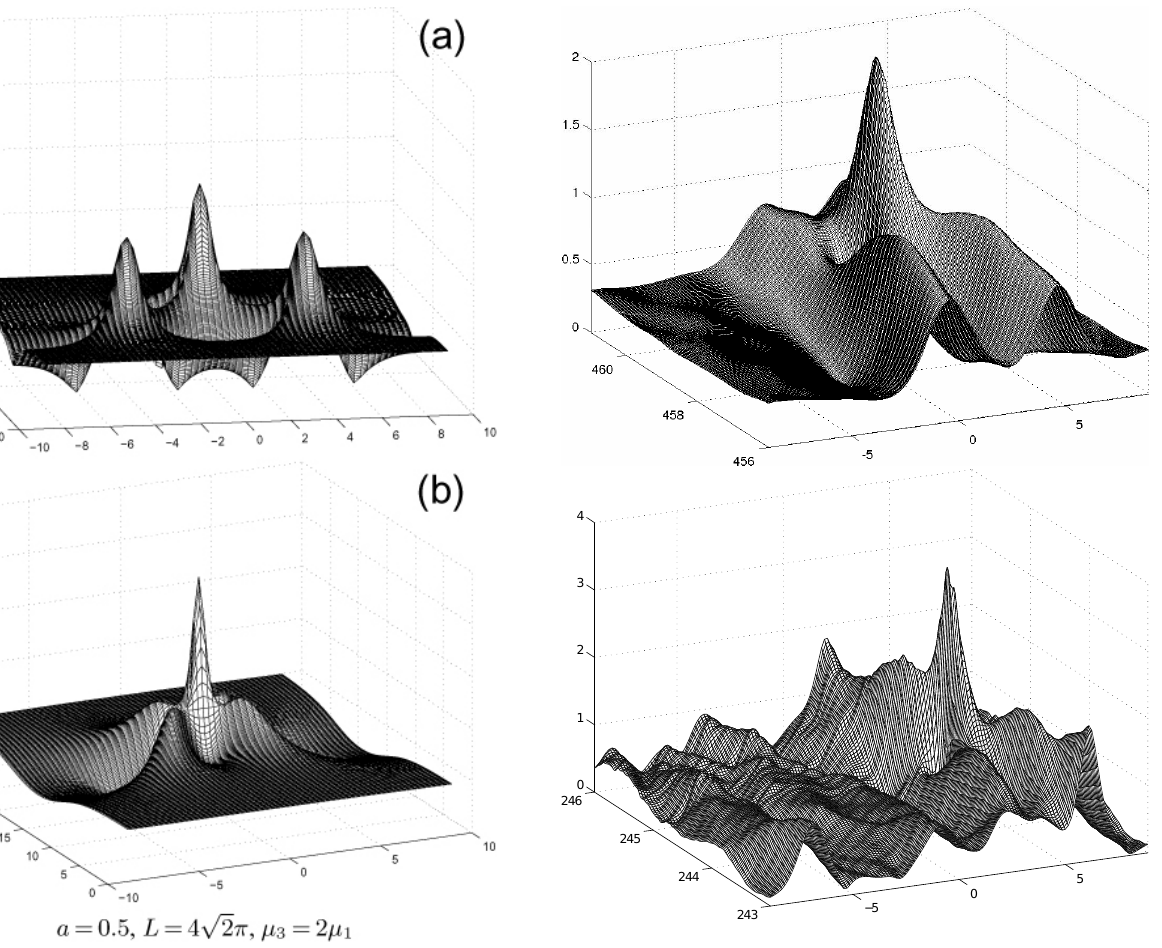
Fig. 4. Rogue waves solutions for the HONLS equation ( (cid:15) = . 05, 0 = β = 0) when (a) two and (b) three unstable modes are